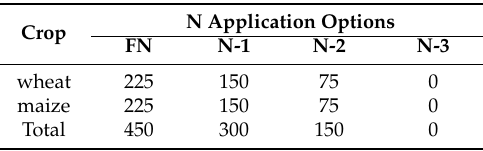
Table 3. N fertilizer options for the wheat-maize rotation system (kg ¨ ha ´ 1 ). FN, farmers’ N practice; N-1, Nitrogen Level